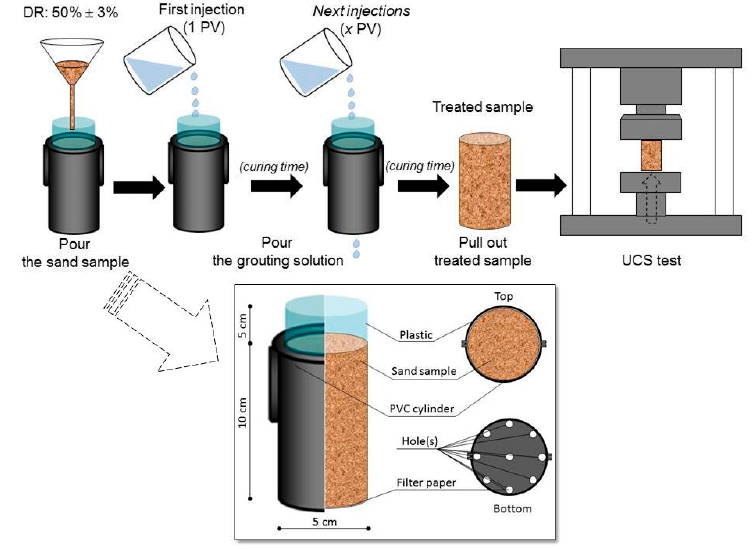
Figure 2. Procedure of sample preparation for UCS test.